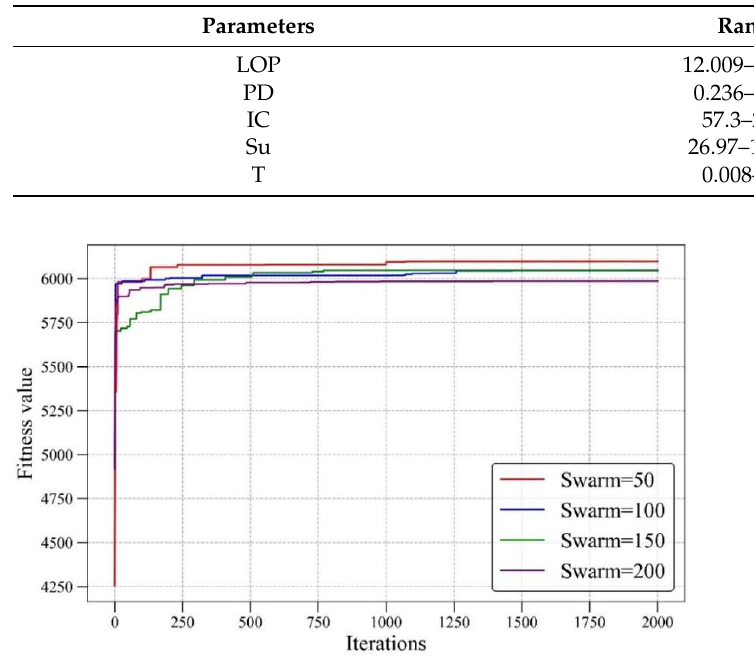
Figure 9. The fitness variation in GWO.